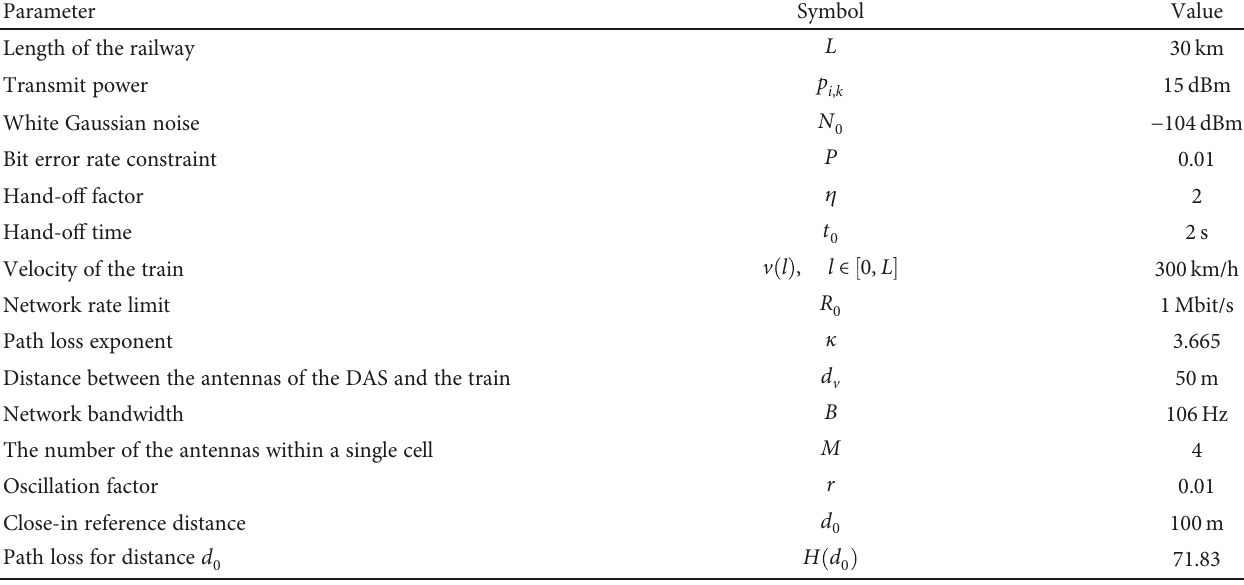
Table 3: Parameter setups of the